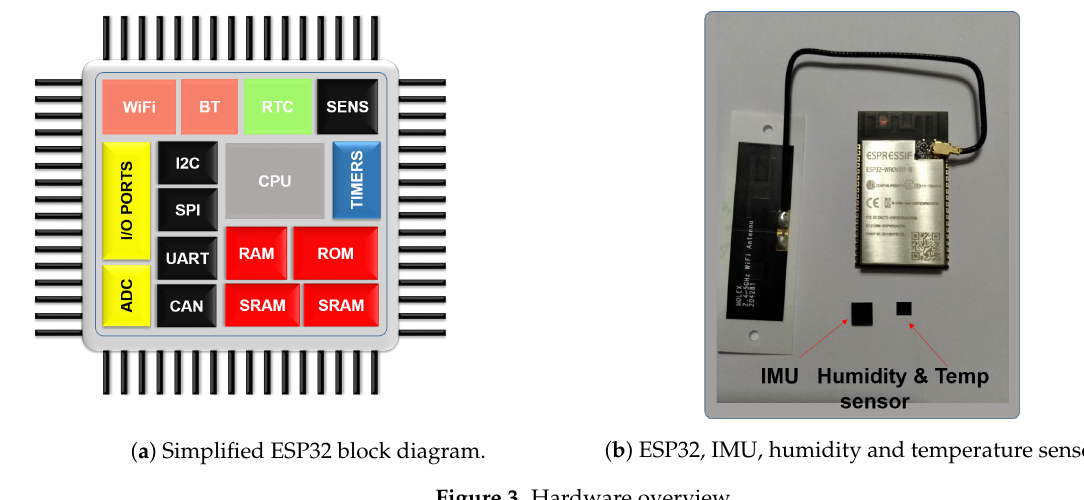
Figure 3. Hardware